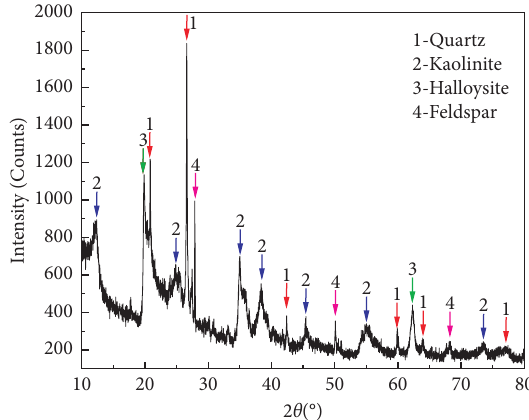
Figure 3: Mineral composition of ion-adsorption rare earth ore.